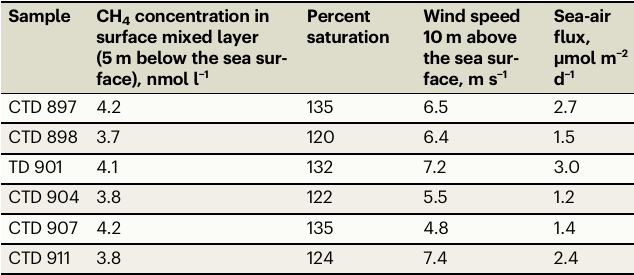
Table 1 | methane concentration in the surface mixed layer and the methane fl uxes from the sea to the air Sample CH 4 concentration in surface mixed